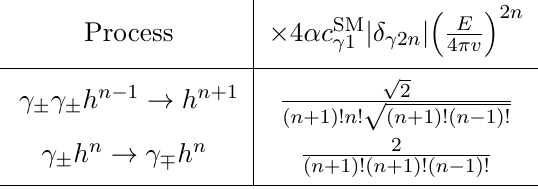
Table 4 . | ˆ M | of the 2 n + 2 -body model-independent unitarity-violating processes arising from the modification of the Higgs coupling to γγ